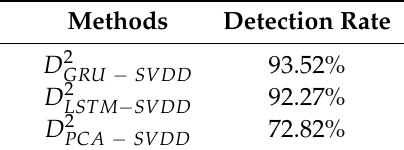
Table 2. Comparison of detection rate for different methods.